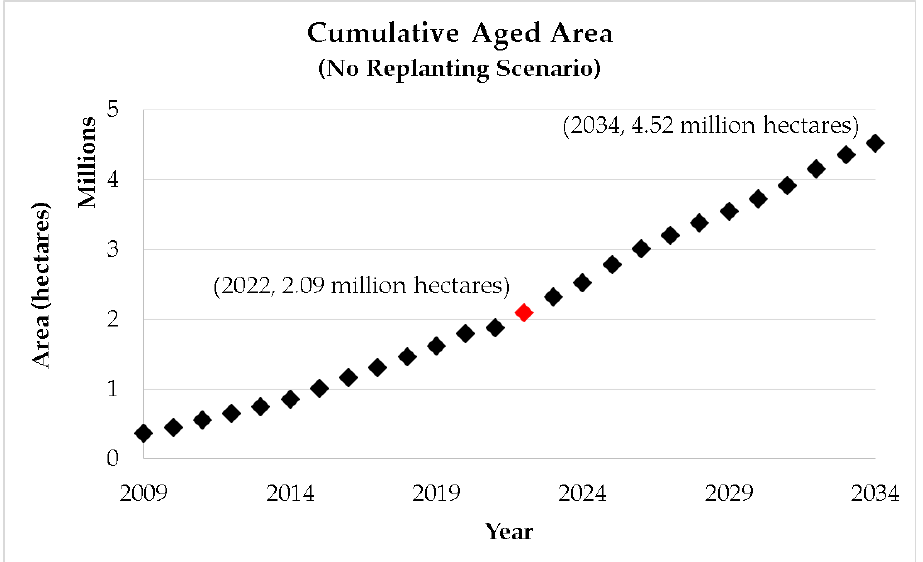
Figure 5. Cumulative hectarage of old oil palm plantation in Malaysia (no replanting scenario). By 2022, the accumulated old plantation is estimated to be 2.09 million hectares or about 41% of the 5.14 million hectares of mature oil palm plantation (Table 3). Ageing of oil palm crops has a huge effect on the country’s palm oil output and the sector as a whole. The backlog of old oil palm trees slows down the improvement of crop yield in